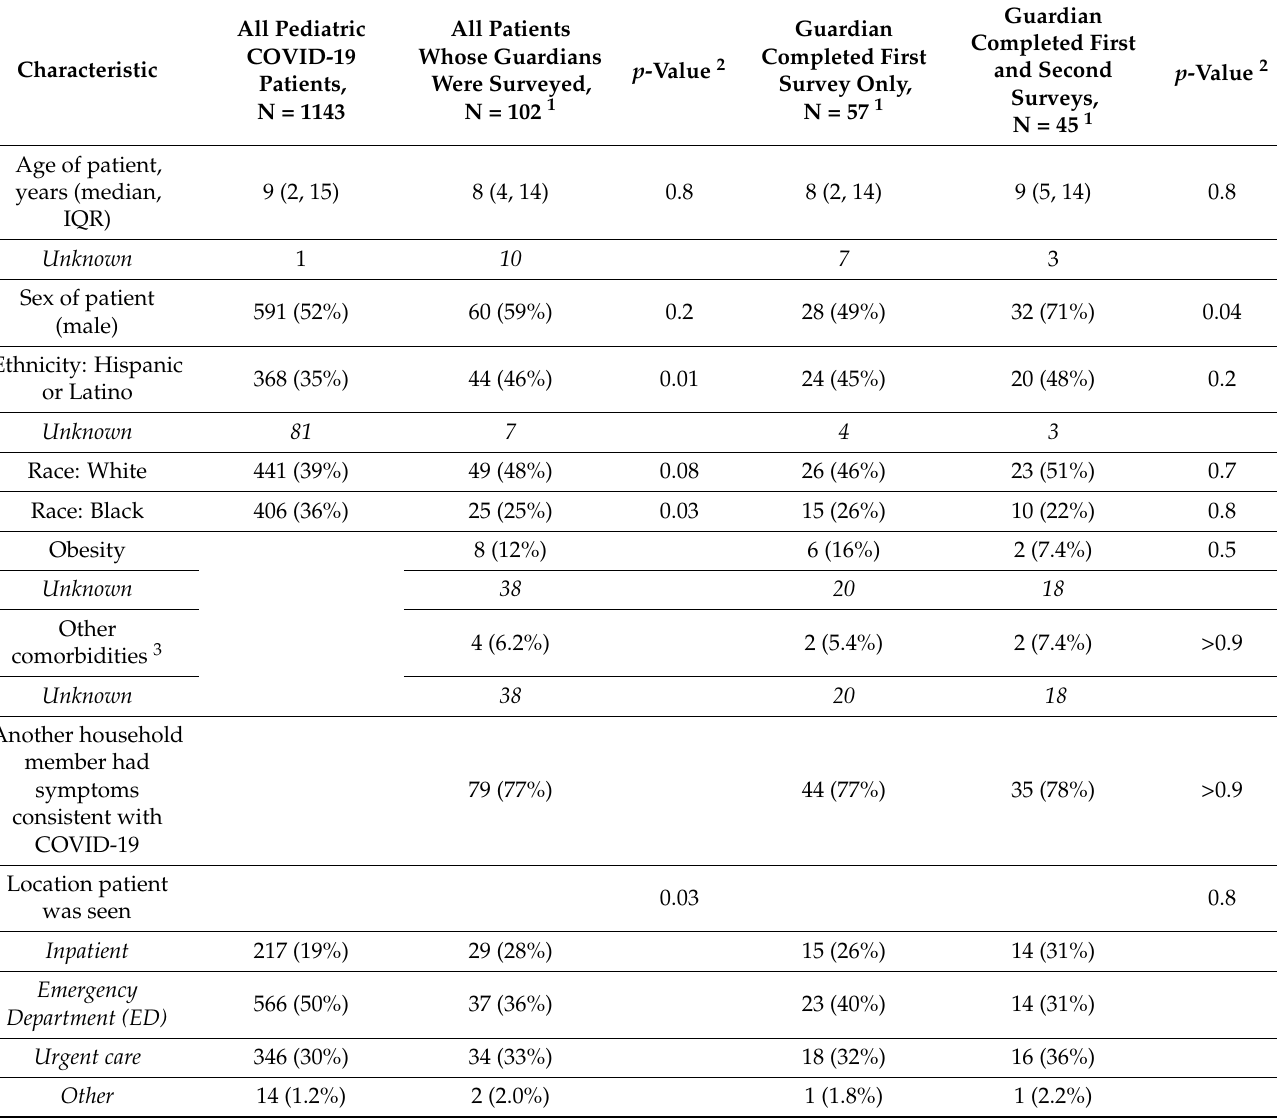
Table 1. Patient demographics: all pediatric COVID19 patients vs. surveyed guardians (first) vs. surveyed guardians (second).